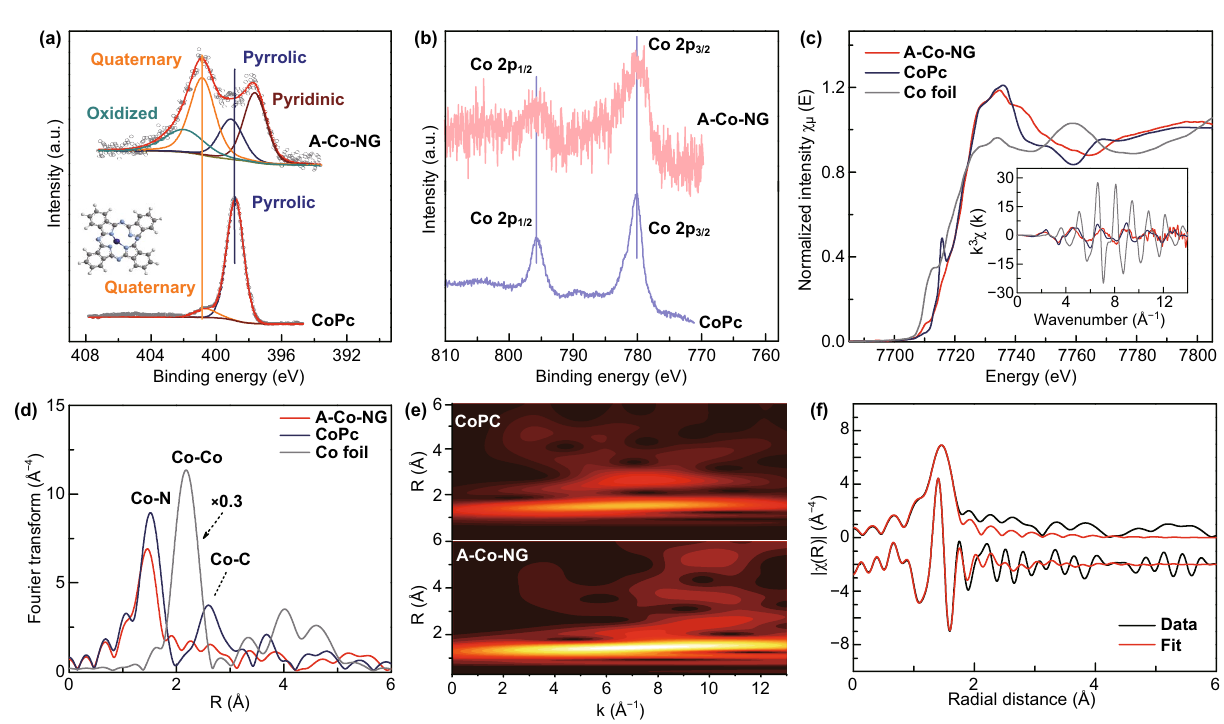
Fig. 2 Characterization of the single-atom catalysts. XPS spectra of a N 1s and b Co 2p for A–Co–NG and CoPc, respectively; c K-edge XANES spectra of A–Co–NG, inset is the k 3-weighted k-space spectra; d Fourier transformed (phase uncorrected) Co K-edge EXAFS spectra; e wavelet transform of the k3 -weighted EXAFS spectrum of the A–Co–NG and CoPc; f First-shell fitting of the Fourier transformation of the EXAFS spectrum of A–Co–NG (the EXAFS spectrum was fitted using the FEFF 8.2